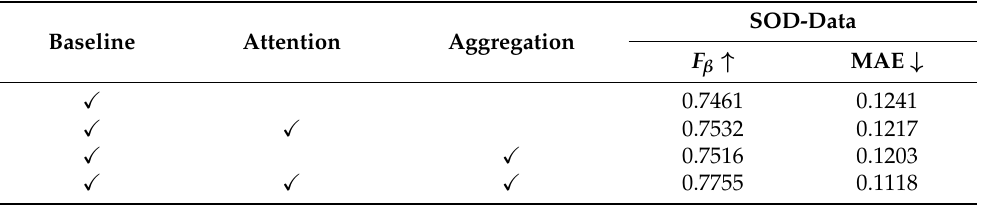
Table 3. Ablation analysis for the proposed architecture on the SOD-data. The evaluation indicators adopt F β , and MAE. Baseline Attention